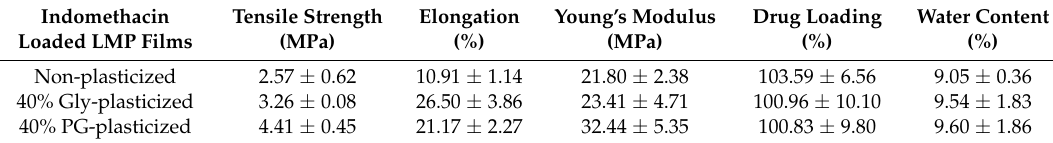
Table 1. Mechanical properties, drug content and water content of non-plasticized, 40% Gly-plasticized and 40% PG-plasticized LMP films containing